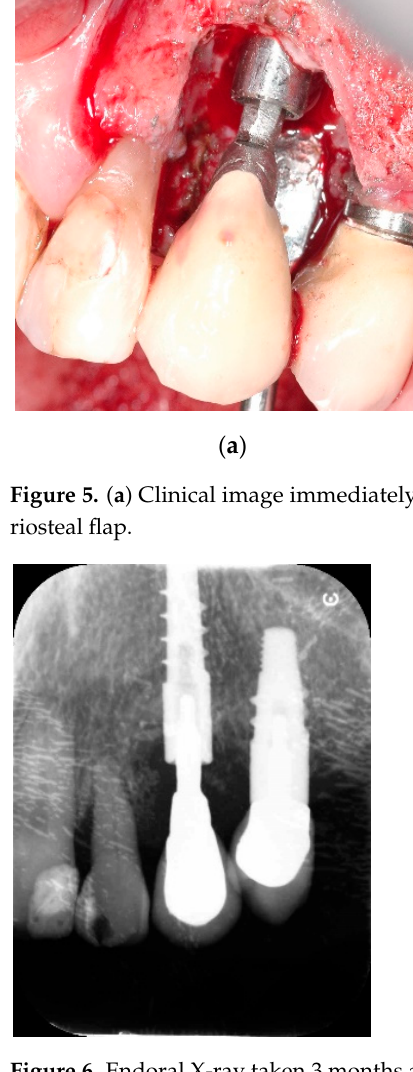
Figure 7. Endoral X-ray taken 12 months after treatment. 5. Conclusions The ability of HYBENX ® to dry the surface and remove biofilm may explain the effi- cacy of the decontamination and subsequent clinical improvements. HYBENX ® treatment can be used for repeated treatments; however, in the cases reported, no further applica- tions were required. After therapy, a marked improvement in clinical and radiographic parameters has been shown. In particular, a significant reduction in soft tissue inflamma- tion and no bleeding on probing using a Teflon probe were noticed. Furthermore, bone gain around the fixture and a decrease in probing depth were achieved. Clinical improve- ments highlight that the procedure reported (OFD + HYBENX ® ) may be considered an effective technique in the treatment of peri-implantitis. Overall, this study is promising and demands further studies to better understand the role and potential benefits of HYBENX ® in the treatment of peri-implant disease. Author Contributions: Conceptualization: P.C.P. and M.A.L.; methodology: P.C.P. and A.D.; software: P.C.P. and E.G.; validation: A.D. and M.A.L.; formal analysis: N.L., F.R.A., and A.S.; investigation: P.C.P. and N.L.; resources: P.C.P. and E.G.; data curation: N.L., F.R.A. and A.L.; writing—original draft preparation: N.L. and F.R.A.; writing—review and editing: P.C.P., N.L. and F.R.A.; visualization: M.A.L. and A.L.; supervision: A.D., G.P. and P.P.; project administration: A.D., P.C.P. and M.A.L. All authors have read and agreed to the published version of the manuscript.